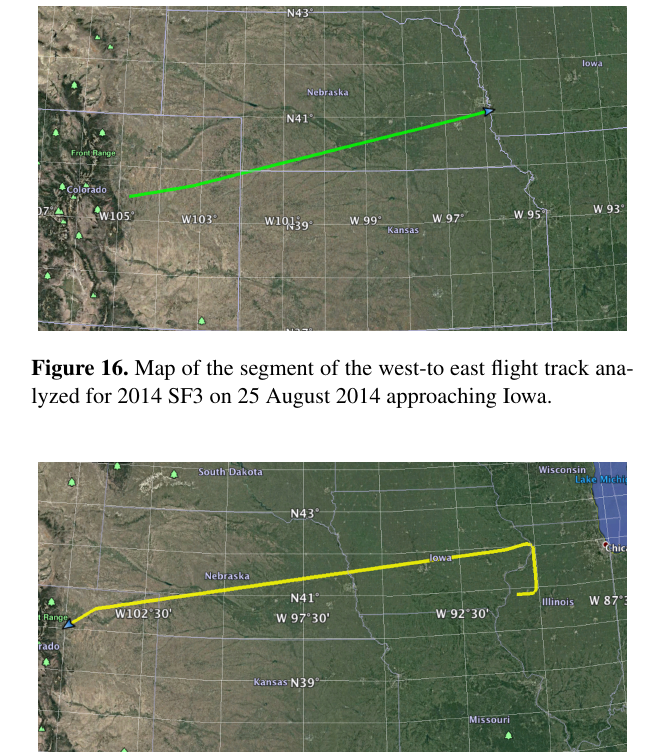
Figure 17. Map of the segment of the east-to-west flight track ana- lyzed during 2014 SF3 on 25 August 2014 when leaving Iowa and approaching Colorado.